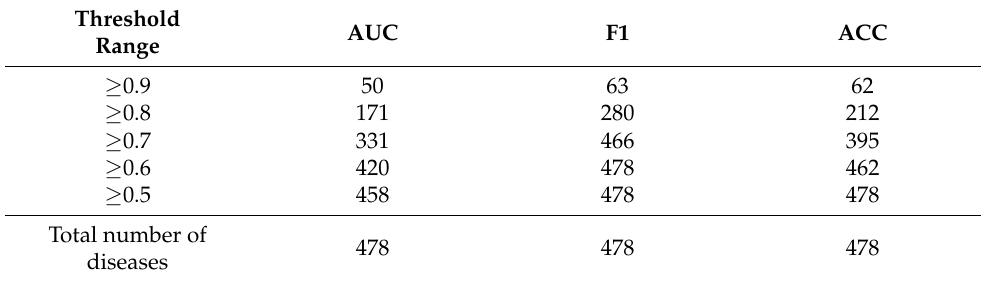
Table 1. Number of diseases with a model performance higher than various